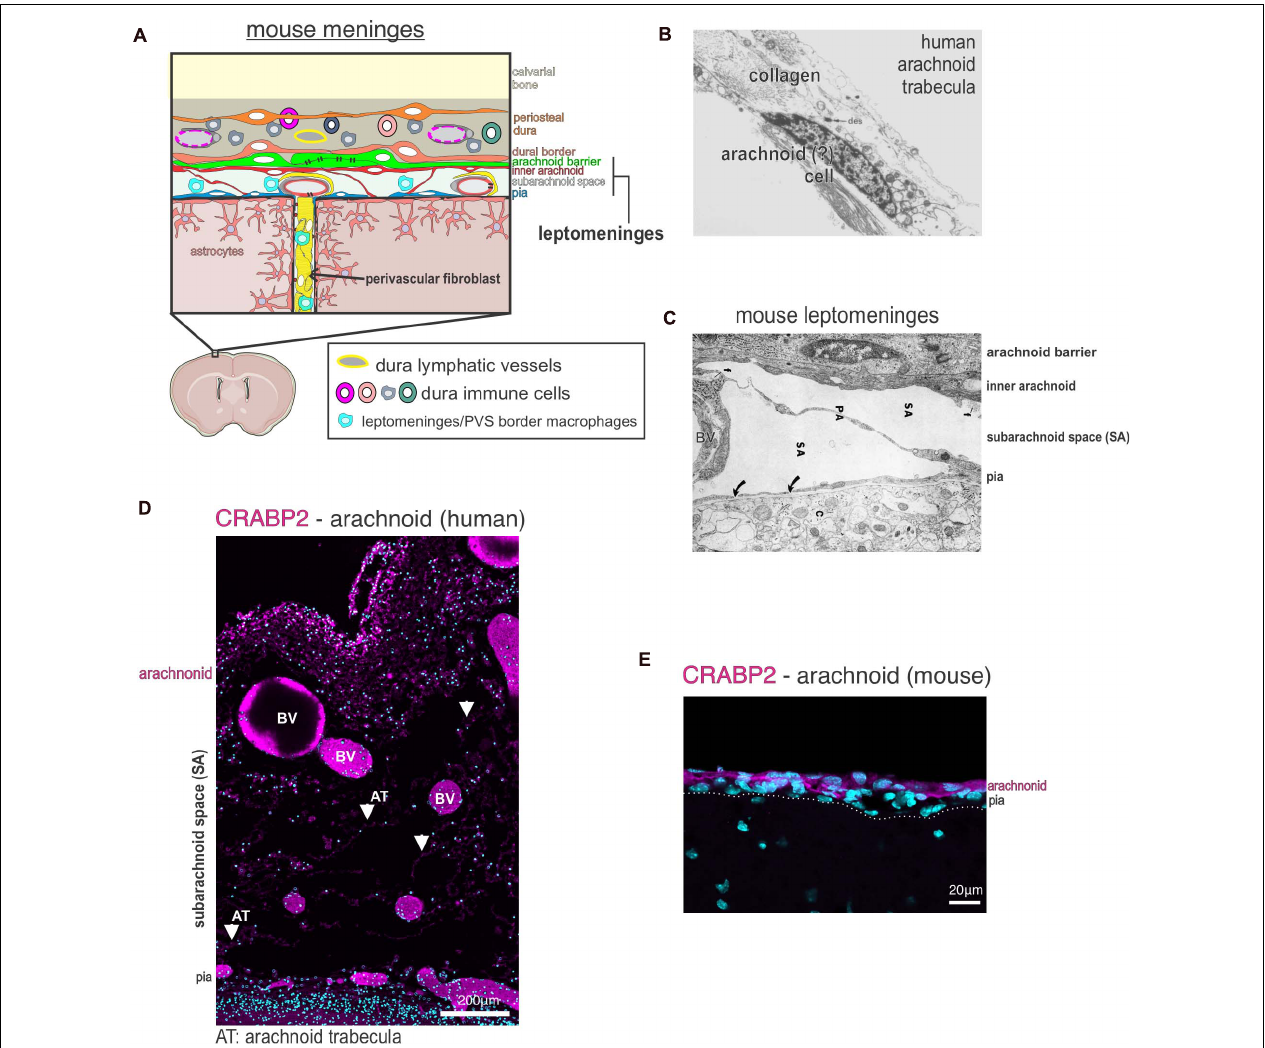
FIGURE 1 | Meninges structure and cellular heterogeneity (A) Schematic of cellular make up and structure of the mouse meninges and contiguous perivascular space. (B) Electron microscopy image of a human arachnoid trabecula, the collagen fibril structures that span the wide of the sub-arachnoid space. A cell, potentially an arachnoid, is seen associated with the collagen fibril. Image reproduced with permission from Alcolado et al. (1988). (C) Electron microscopy image of the mouse leptomeninges, a “pia-arachnoid” cell process (PA) spans the subarachnoid space (SA) containing blood vessels (BV). Cells of the inner arachnoid are immediately adjacent to the arachnoid barrier cell layer, which contains microfibrils (f) of extracellular matrix material. Image reproduced with permission from McLone and Bondareff (1975). (D) Immunofluorescence image of human fetal leptomeninges in the Sylvian sulcus labeled with CRABP2 (magenta) and DAPI (cyan). CRABP2 immunoreactivity in the meninges is limited to the arachnoid layer and cells associated with the arachnoid trabecula (AT) in the subarachnoid space (SA). Image reproduced with permission from DeSisto et al. (2020). BV, blood vessels. (E) Immunofluorescence image of mouse leptomeninges at postnatal day 14 labeled with CRABP2 (magenta) and DAPI (cyan). CRABP2 immunoreactivity is seen in cells of the arachnoid layer but not in pia-located cells. Image reproduced with permission from DeSisto et al.